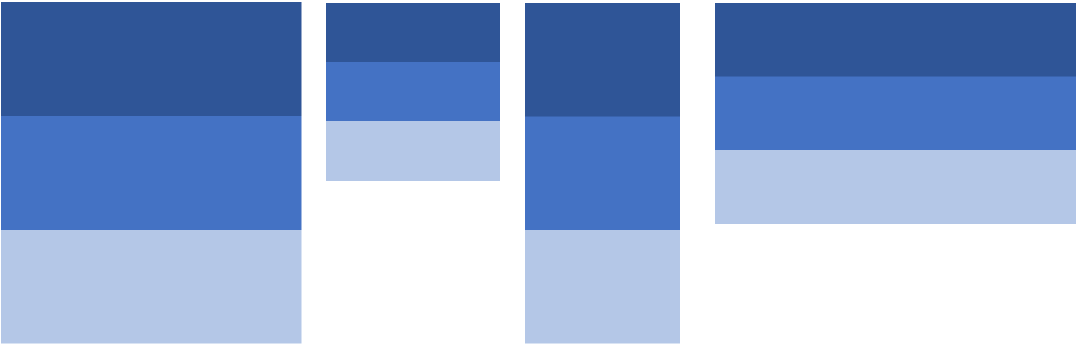
Figure 5. Example of a random population of four individuals.